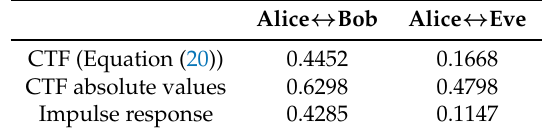
Table 1. E [ ρ ] of the channel transfer function in different cases. CTF, channel transfer function.